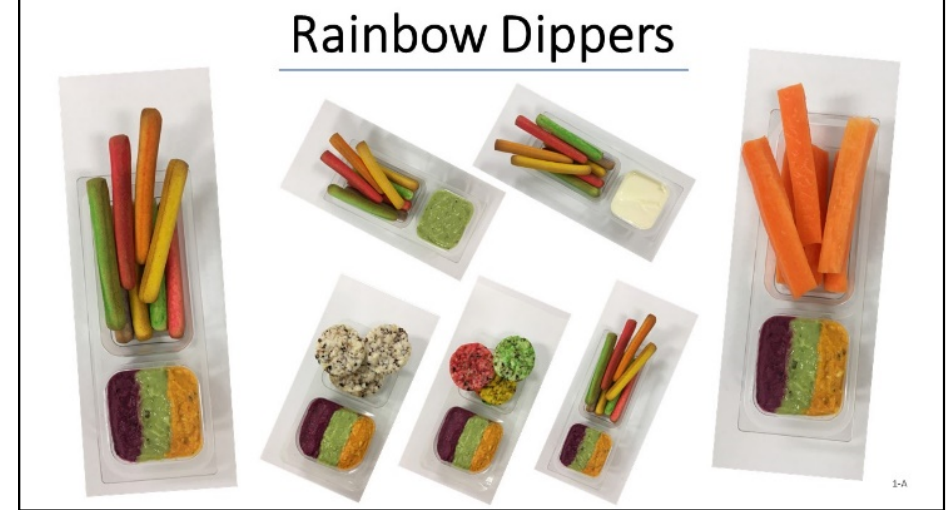
Figure 1. Example of concept presentation for evaluation with children. Table 2. Concept name, description, and all potential appealing attributes from the literature and product mapping.